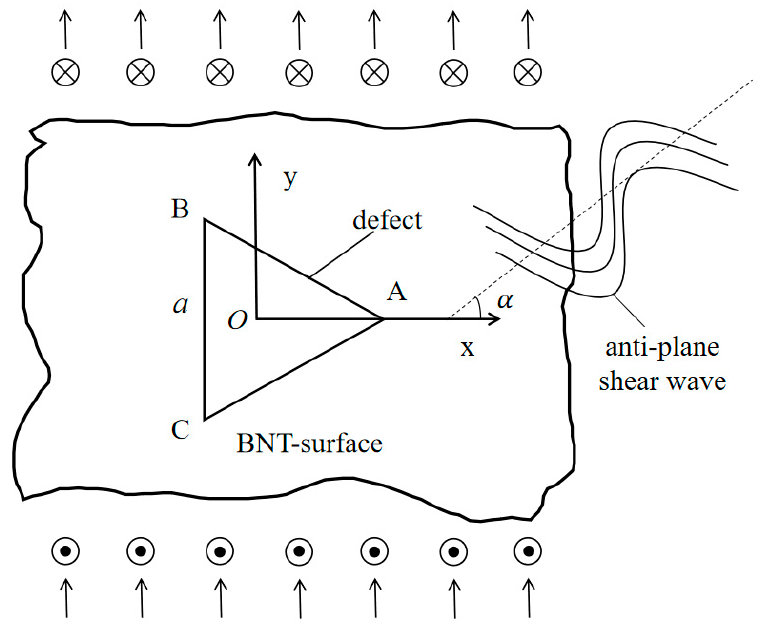
Figure 1. A triangular hole in BNT materials and the wave simulation.